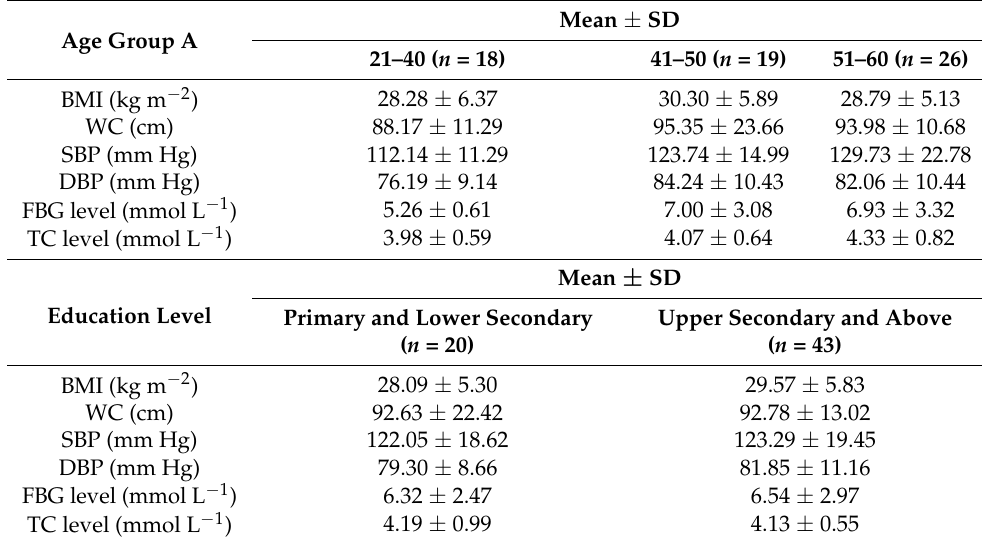
Table 3. Mean and standard deviation differences between CVD risk factors, age group, and educa- tion